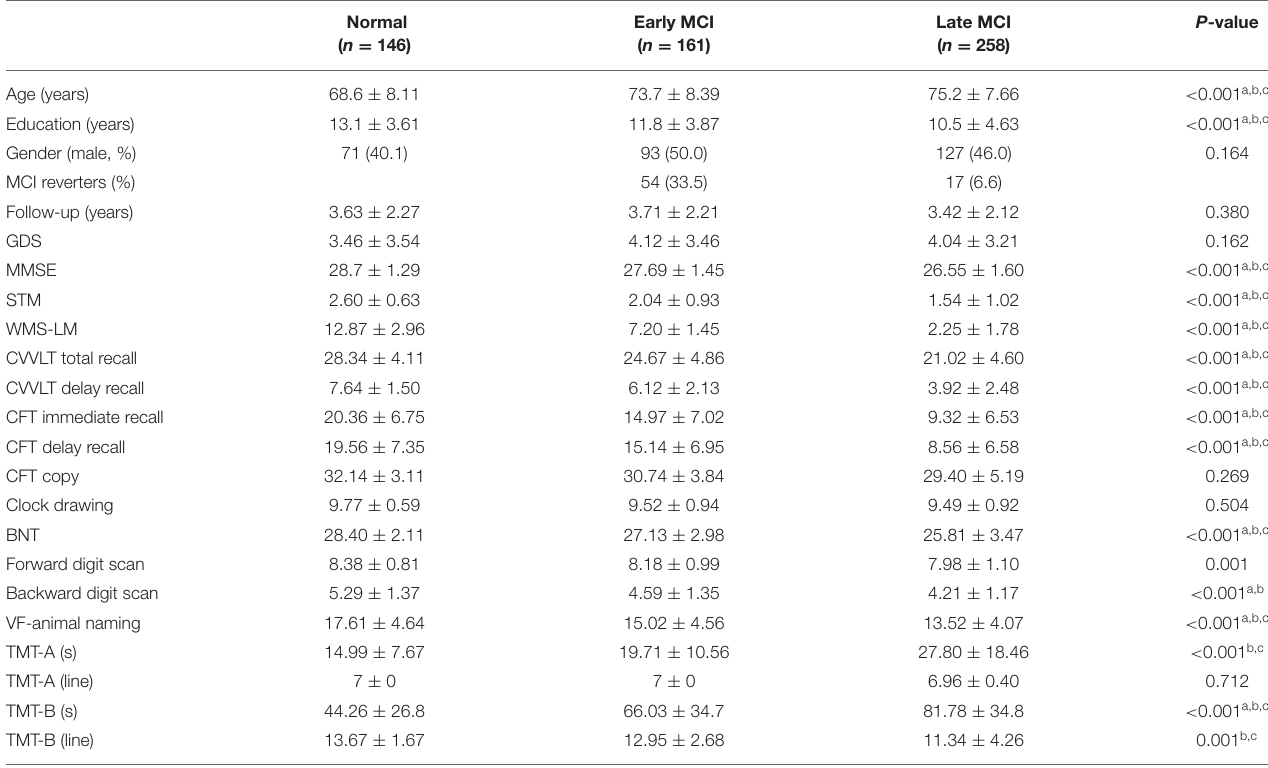
TABLE 1 | Demographic data and baseline neuropsychological performance.